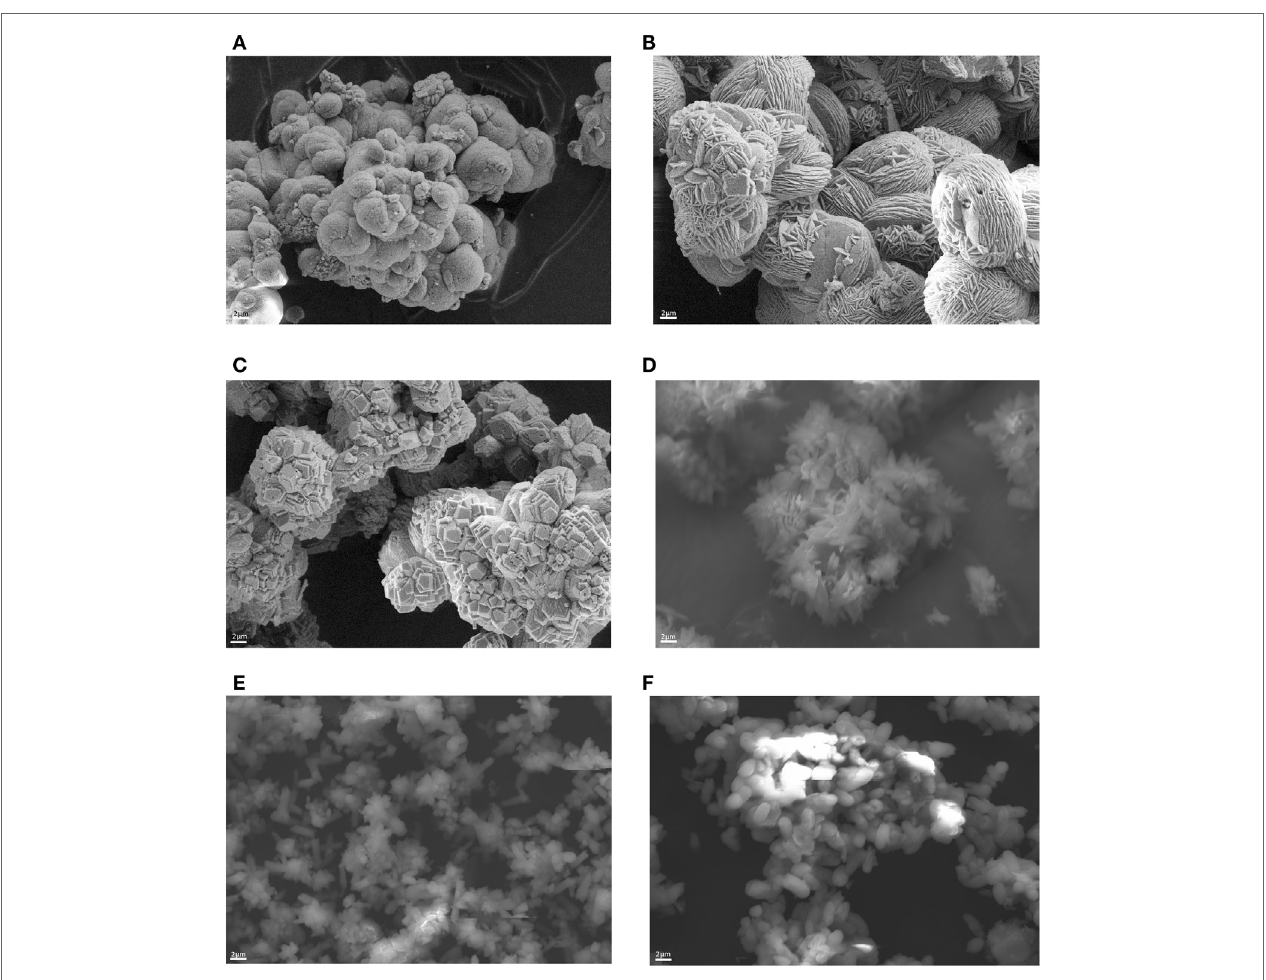
FigUre 4 | seM pictures of the produced carbonates . Scale bars 2 μ m in (a–F)